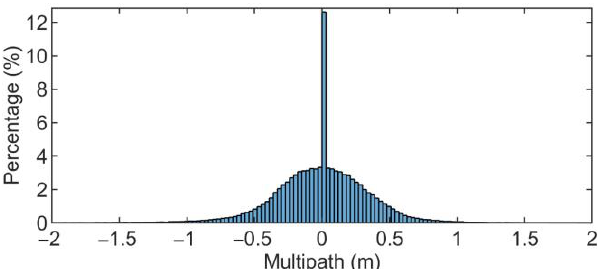
Figure 4. The distribution of the code pseudorange variations at the G3 frequency of all the M+ and K satellites. The observation data of 145 MGEX stations on DOY 325, 2020, as shown in Figure 1, were utilized, and more than 400,000 code pseudorange errors were counted.